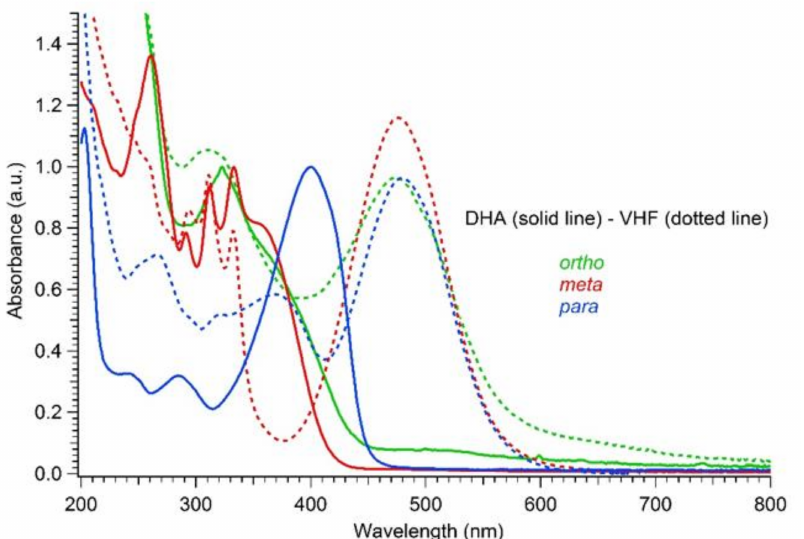
Figure 6. Normalized UV-Vis absorption spectra in MeCN of DHAs (solid line) and VHFs (dotted line) for ortho -dimer 4 (2.05 × 10 − 5 M, green), meta -dimer 5 (4.2 × 10 − 5 M, red) and para -dimer 6 (1.7 × 10 − 5 M, blue).